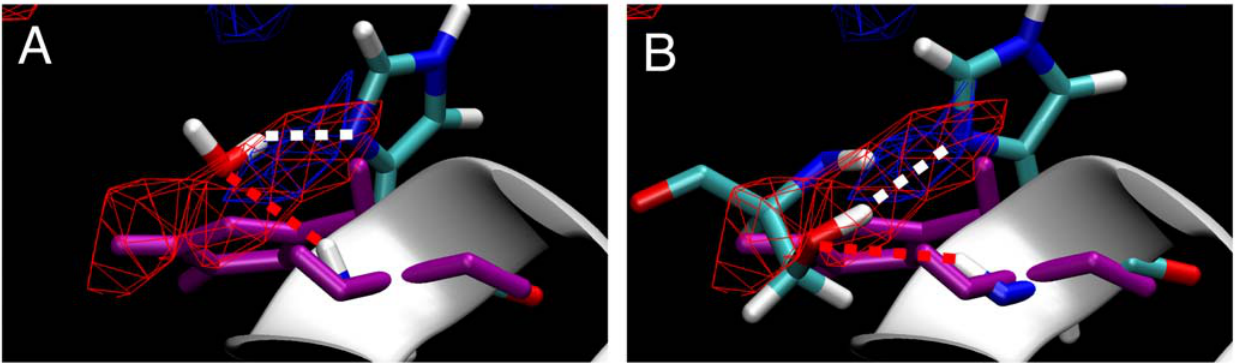
Figure 6. Conformations of BCL-6 His116 in the BCL-6:SMRT cocrystal, sampled during SILCS MD, and in the BCL-6:BCOR cocrystal. (A) The BCL-6:SMRT cocrystal His116 conformation used to seed the simulations (purple) overlaid with a SILCS MD snapshot of the His116 conformation having an interacting water molecule (colored by atom type). (B) The BCL-6:SMRT cocrystal His116 conformation (purple) overlaid with the BCL-6:BCOR cocrystal His116 conformation and BCOR Ser508 (colored by atom type). The hydrogen bond donor FragMap is shown as a blue isocontour mesh, the hydrogen bond acceptor FragMap as a red isocontour mesh, and the helix containing His116 is represented as a white ribbon.